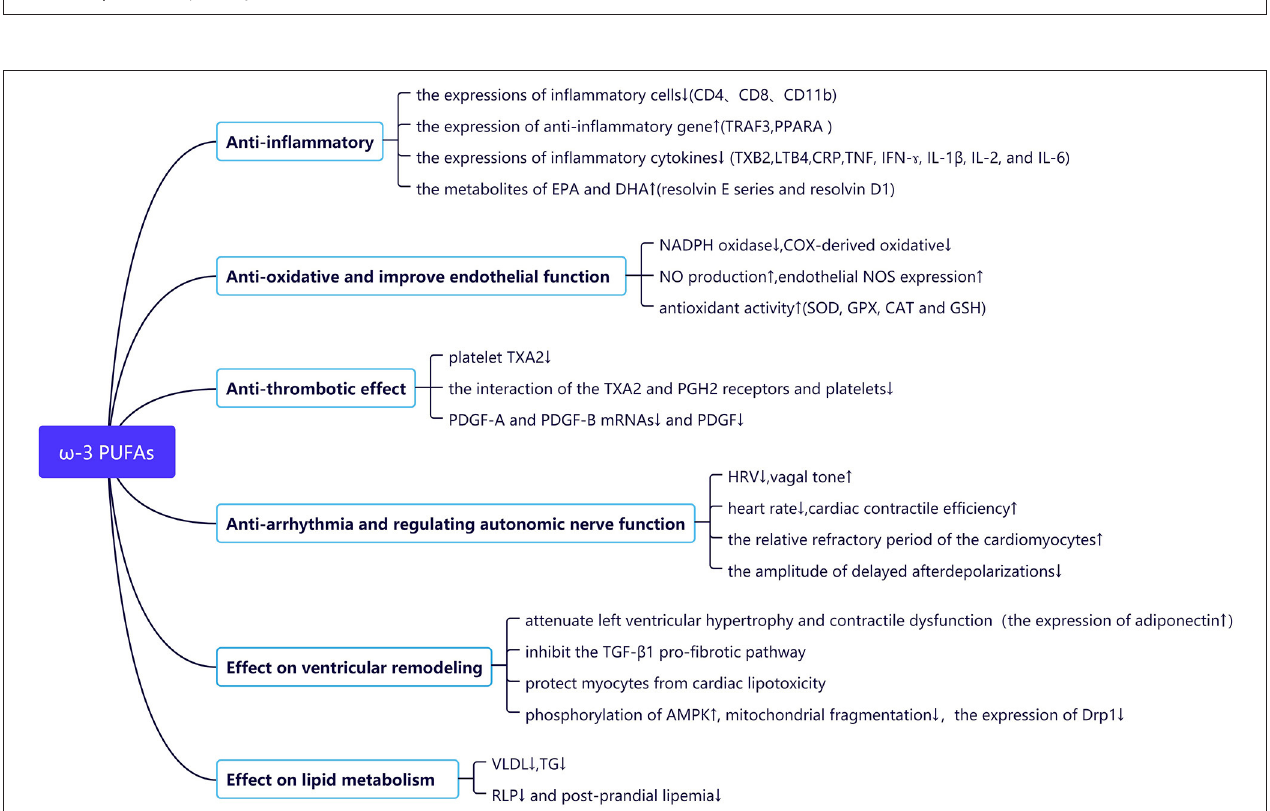
FIGURE 2 | Potential molecular mechanisms for cardiovascular protective effects of the ω -3 PUFAs.